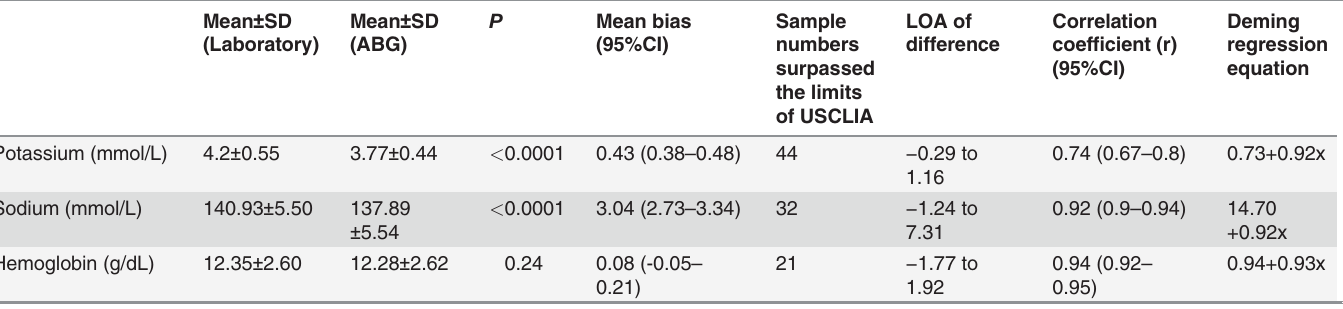
Table 2. Comparison of the potassium, sodium, and hemoglobin results obtained by the arterial blood gas analyzer and the hospital